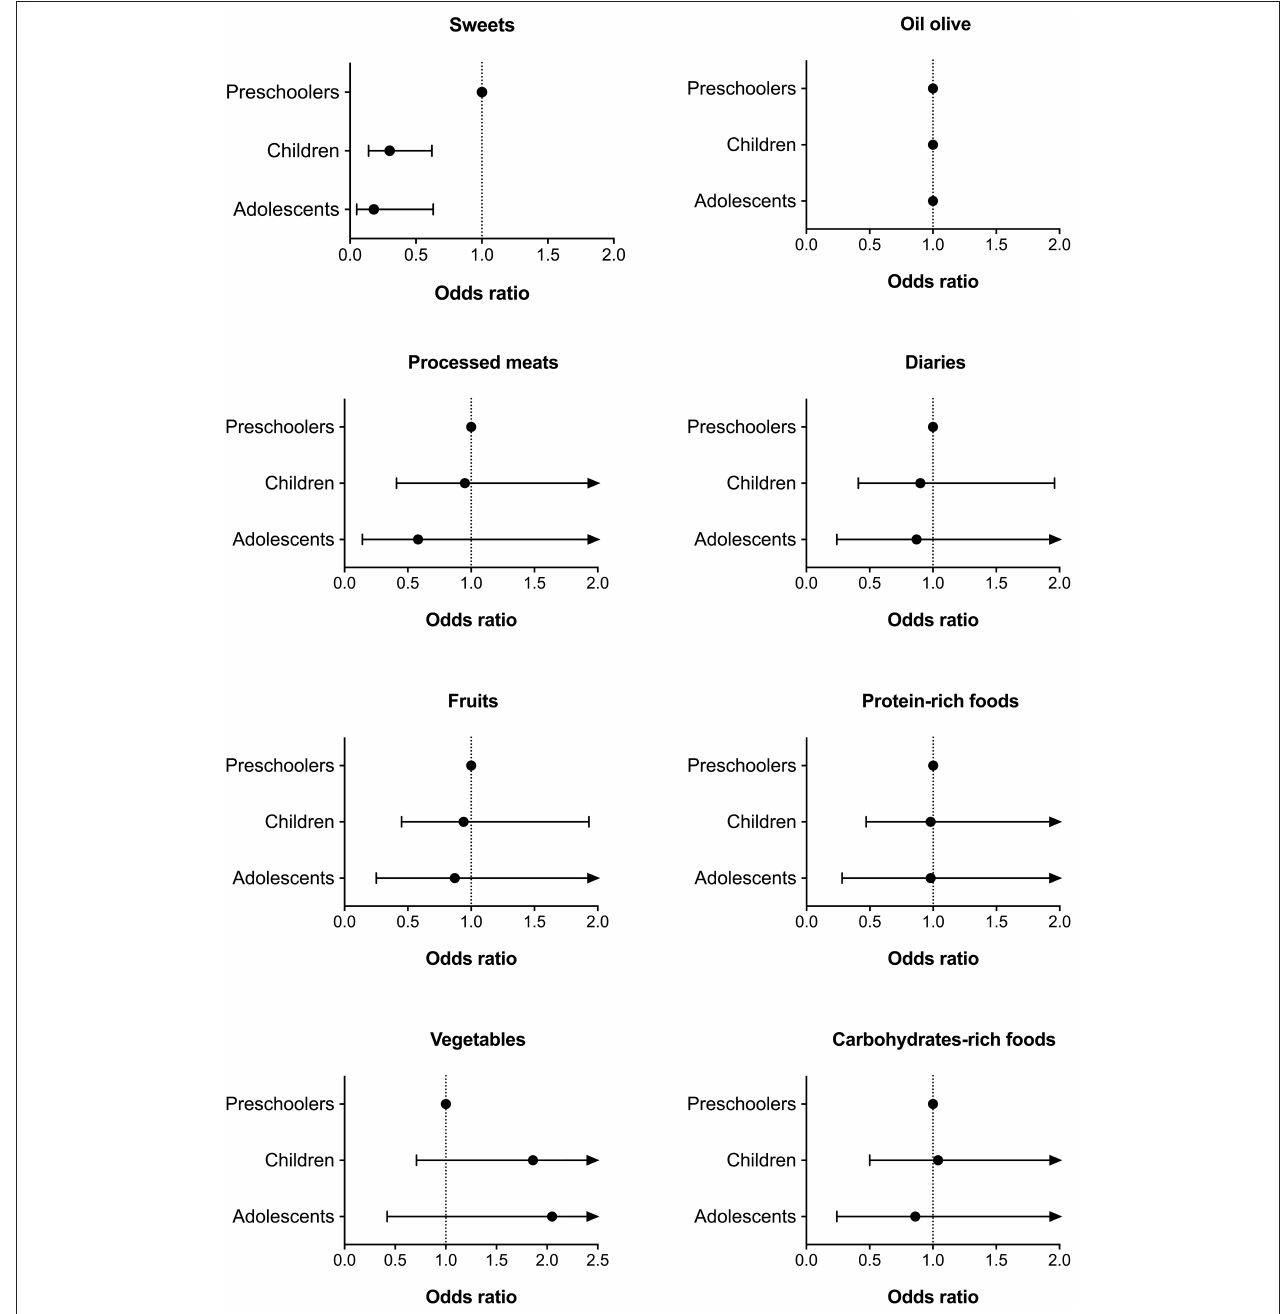
FIGURE 2 | Association of meeting the different Food-Based Dietary Guidelines according to age group. Data expressed as odds ratio (confident intervals 95%). Adjusted by sex, socioeconomic status, educational level, geographical location, body mass index (z-score), and physical activity level.